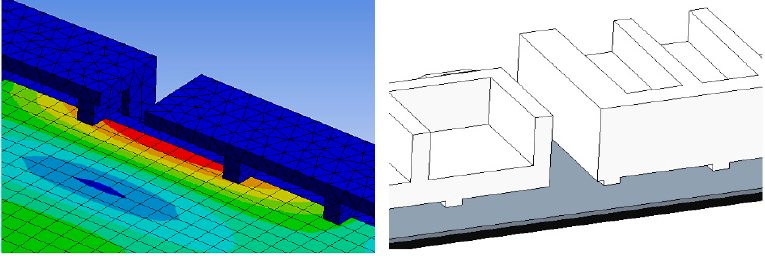
Figure 15. FEA Figure 15. FEA result.